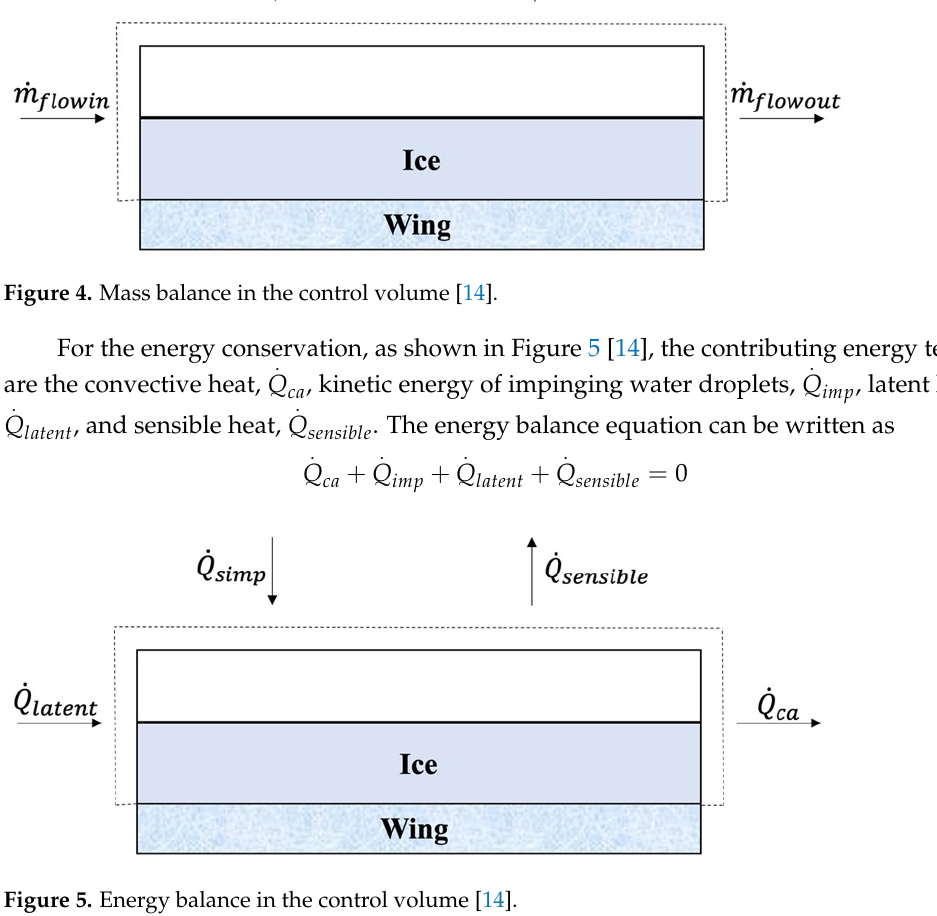
Figure 5. Energy balance in the control volume [14]. By solving the mass balance and energy balance equations, the ice layer thickness distribution can be obtained. Many studies [12–14] have shown that this approach can give good agreement with the experimental data